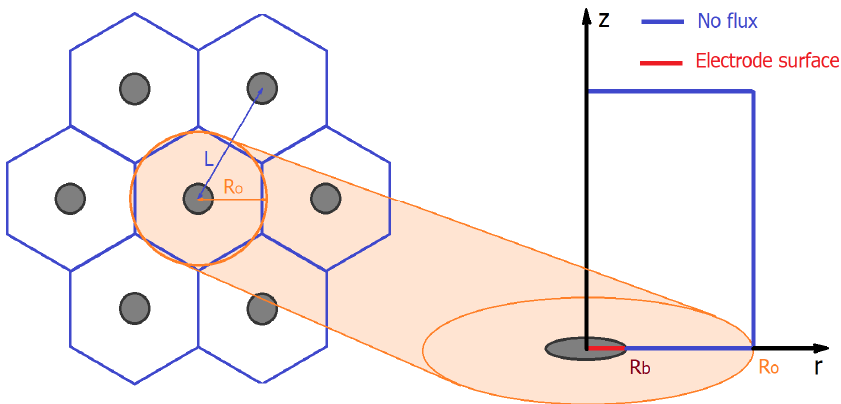
Figure 1. Geometric formulation of the boundary conditions for the model of a hexagonally ordered ensemble of disk ultramicroelectrodes.